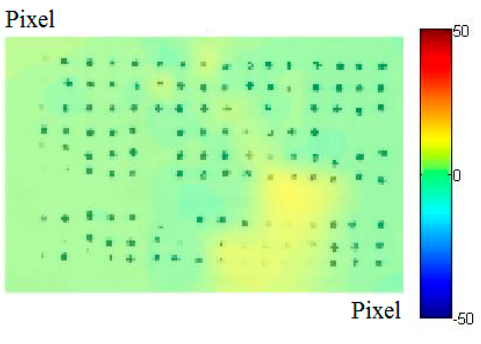
Figure 6. Displacement field.